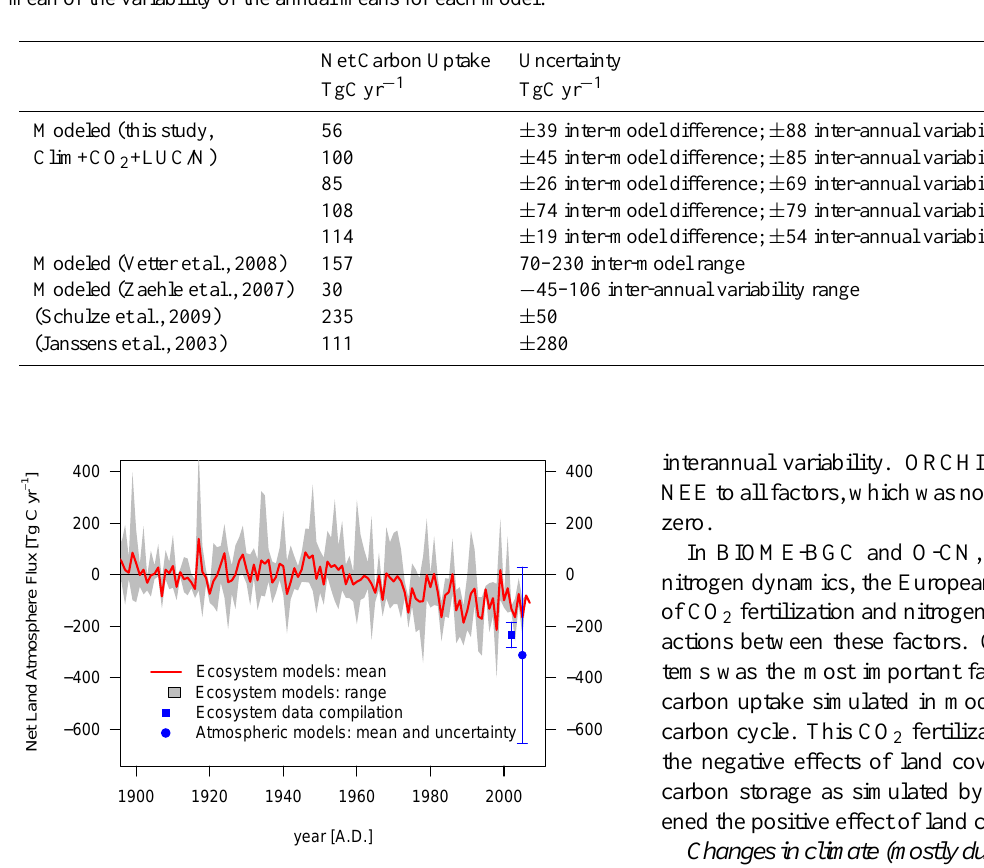
Fig. 2. European net land-atmosphere carbon flux in 20th century estimated with ecosystem models. Red line is an average value es- timated with three ecosystem models (BIOME-BGC, ORCHIDEE, and JULES). The gray shaded area depicts the models’ range. Mod- eled carbon balance at the end of the 20th century is lower than the mean value of carbon balance from the ecosystem model compila- tion (blue square) or the inverse estimations of atmospheric models (blue dot) (Schulze et al., 2009) reported as an average for 2000–